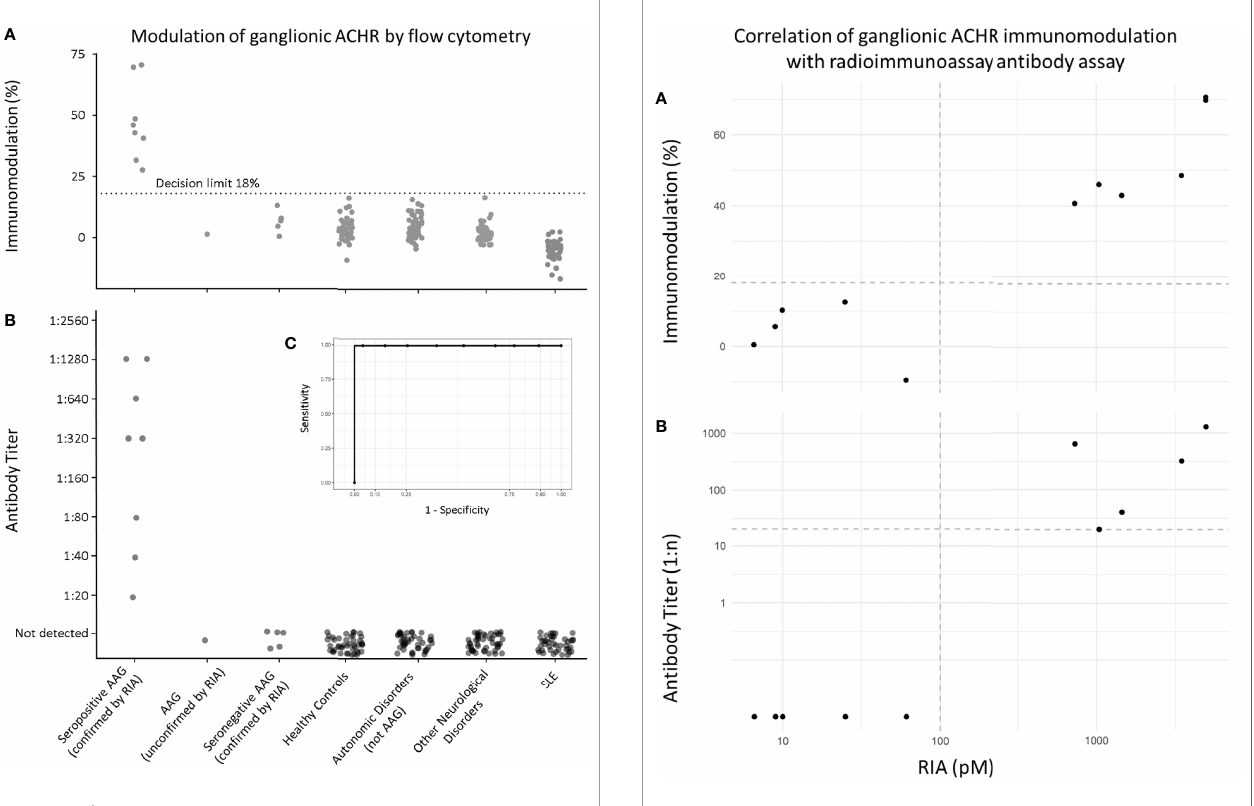
FIGURE 4 | (A) Correlation of fl ow cytometric-based immunomodulation assay (1:20 screening dilution) with radioimmunoprecipitation assay (RIA). Decision limits set at 18% immunomodulation and 100pM respectively. Correlation (Spearman r = 0.897). The RIA values from the seropositive AAG samples from Oxford ranged from 730-3464pM (RI < 100). (B) Correlation of fl ow cytometric immunomodulation endpoint titer results (decision limit set at positivity starting at 1:20 dilution) and RIA. Correlation (Spearman r =